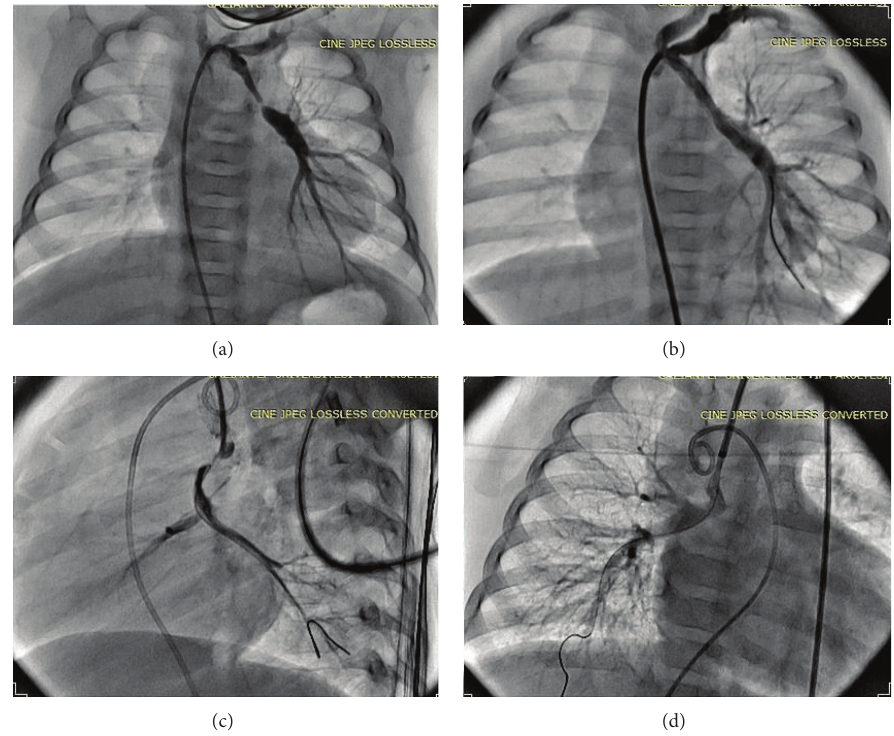
Figure 1: (a) Angiography via the femoral artery showing the left-sided PDA and left pulmonary artery with very severe distal ductal stenosis. (b) Angiography performed after stent placement in the left-sided PDA. Distal stenosis of the PDA has been relieved. (c) Angiography via the right carotid artery showing the right-sided tortious stenotic PDA and right pulmonary artery at the lateral projection. The right-sided PDA arises from the underside of the aortic arch and runs parallel to the descending aorta. (d) Angiography performed after stent placement in the right-sided PDA from the right carotid artery at the anteroposterior projection. The direction of the guiding catheter is